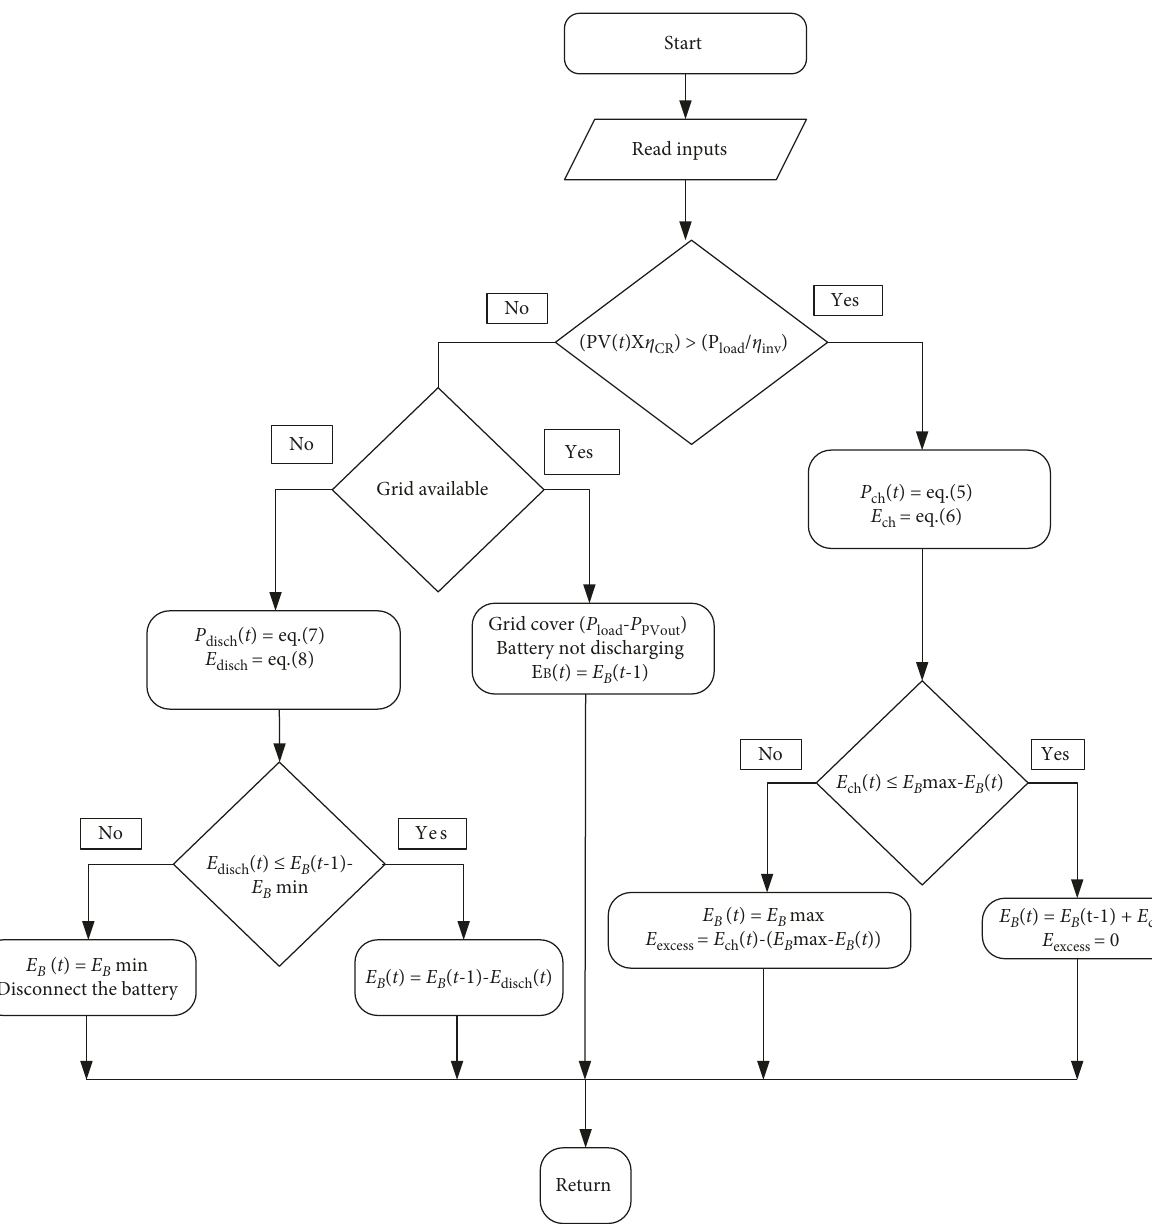
Figure 5: Flow chart used for system